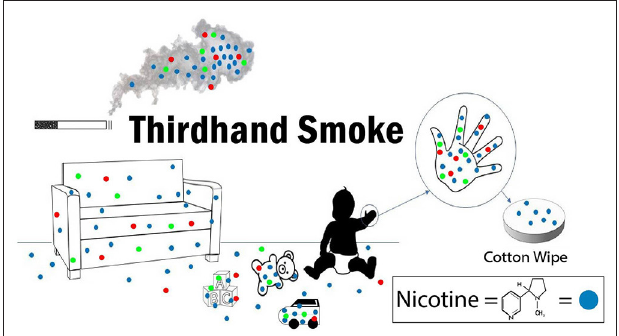
FIGURE 1 | Graphical depiction of thirdhand smoke and hand wipe